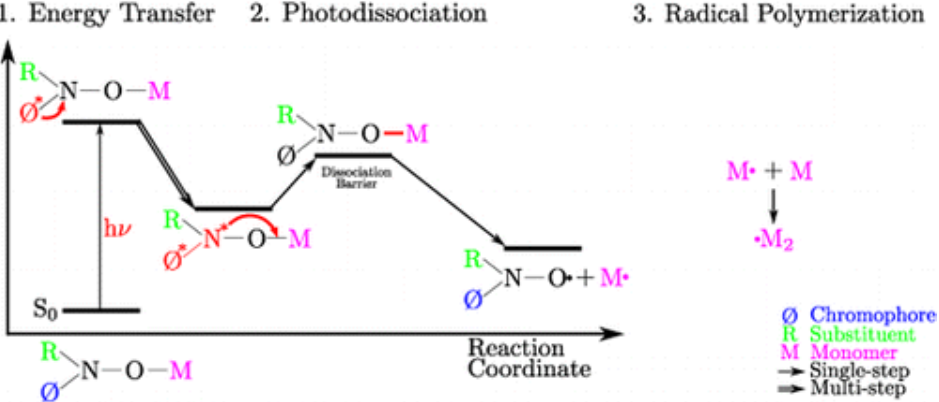
Figure 5. General scheme of the photochemically induced NMP2 initiation mechanism. The red part of the structure indicates the localization of the excitation energy in the structure. Reprinted with permission from (Huix-Rotllant, M.; Ferré, N. Theoretical Study of the Photochemical Initiation in Nitroxide-Mediated Photopolymerization. J. Phys. Chem. A 2014 , 118 , 4464–4470). Copyright (2014) American Chemical Society."